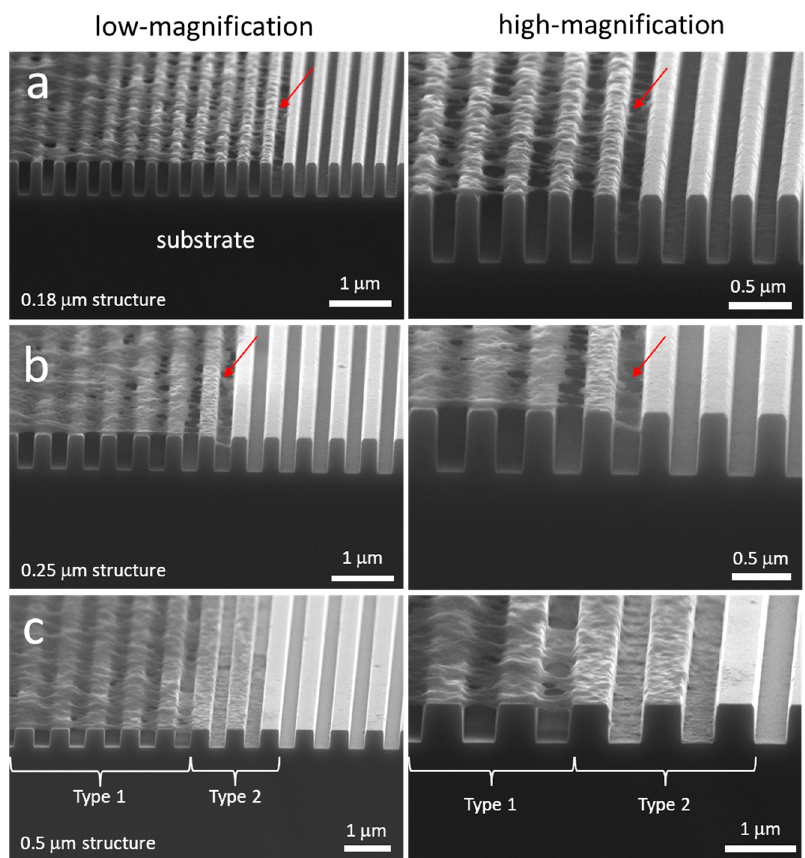
Figure 7. SEM micrographs 70° tilted of cross-sectioned cells on comb structures with line widths of ( a ) 0.18 μ m, ( b ) 0.25 μ m, and ( c ) 0.5 μ m. Two distinct types of cell adhesion morphologies are observed: Type 1—Adherent cells on 0.18 μ m and 0.25 μ m structures only contacted the top portion of lines but did not fill the trench gaps; and Type 2—Cells exhibit conformal surface coverages. Both morphology types were observed for adherent cells on the 0.5 μ m comb structures. All cells were incubated on the structures for 24 h. Cell concentration was ~5 × 10 5 cells/mL.